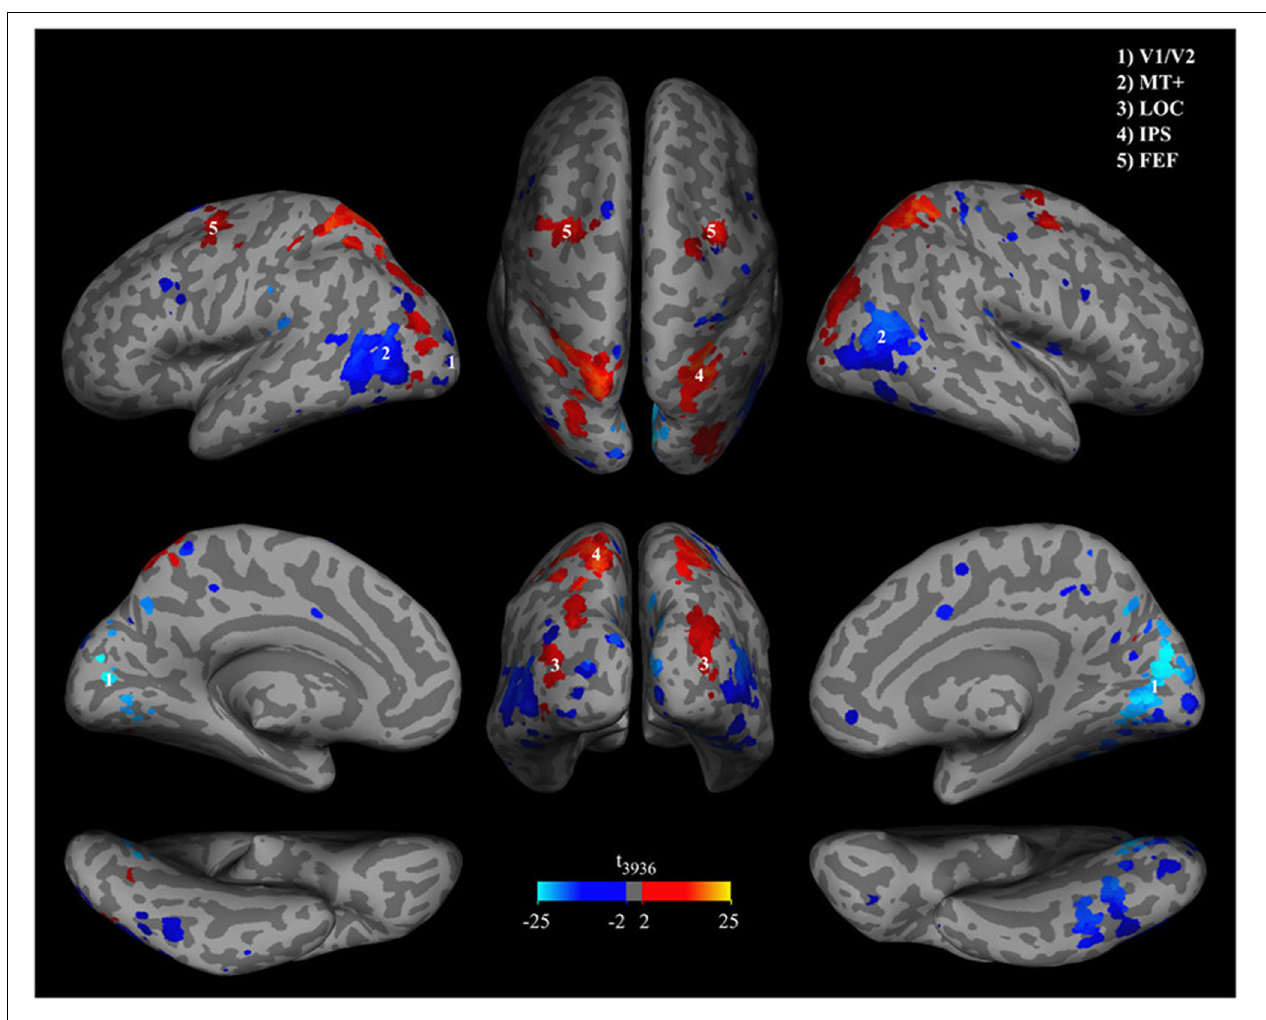
FIGURE 5 | Significance of classifier weights and activation differences. Brain patterns were extracted from the group classifiers of both offline and online experiments and overlaid on an MNI template. Brain regions were masked by p -values of classifier